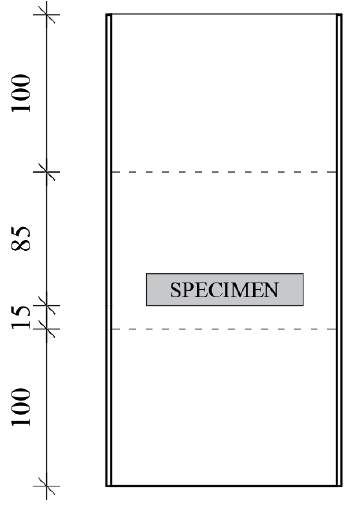
Figure 6. Specimen position inside the cylindrical mold (in mm).